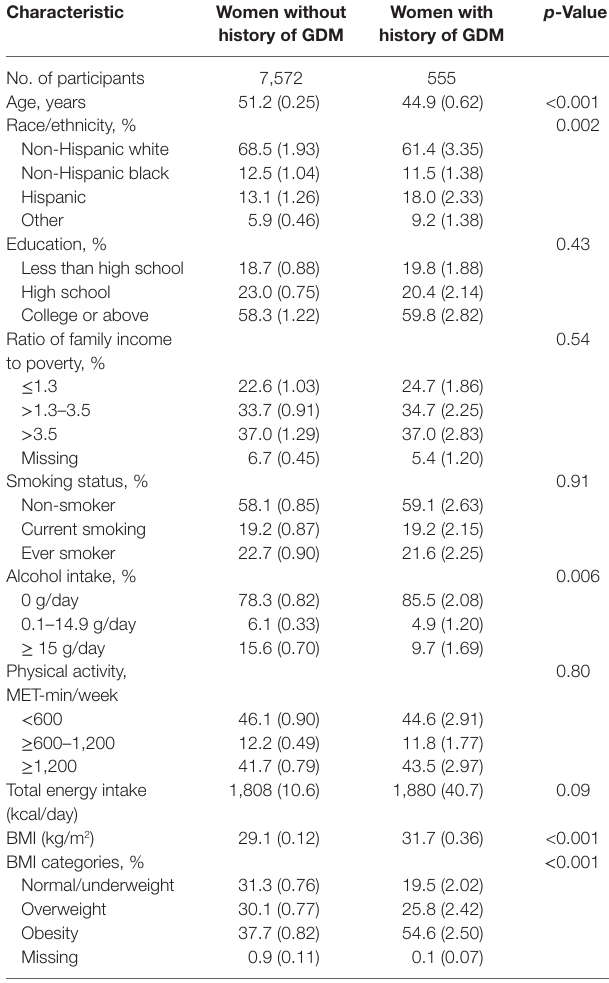
TaBle 1 | Characteristics among parous women with or without a history of